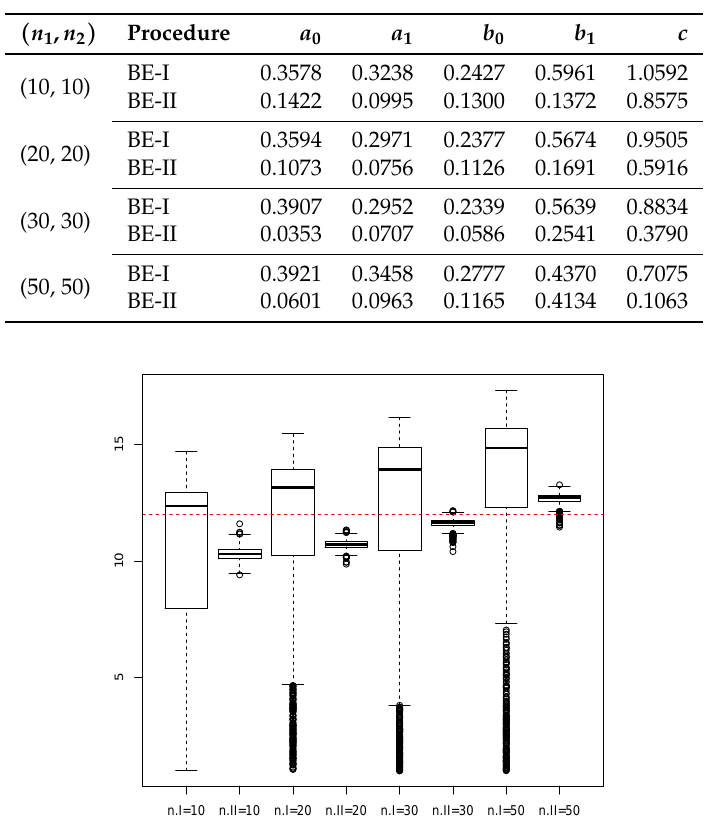
Figure 1. The boxplots of 1000 Bayes estimates of a 0 , where “n.I” and “n.II” indicate that procedures BE-I and BE-II are implemented with sample size n , respectively.